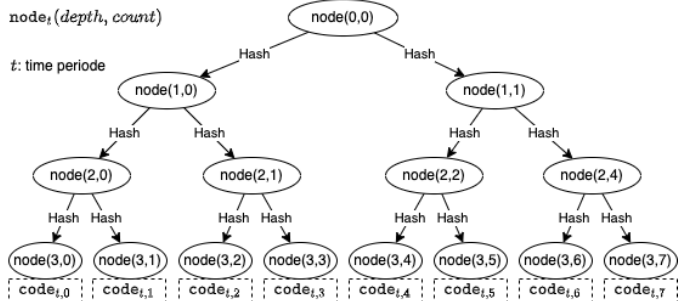
Figure 1. Binary tree activation code